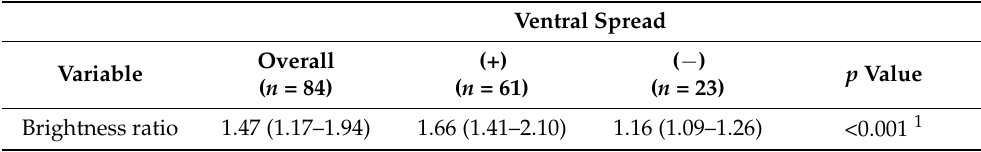
Table 4. Association between ventral spread and grayscale brightness